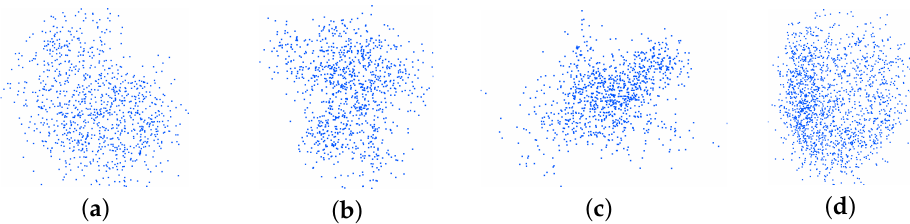
Figure 12. Point clouds with Gaussian noise, σ = 0.15: ( a ) Stanford Bunny; ( b ) Armadillo; ( c ) airplane; ( d ) human face.